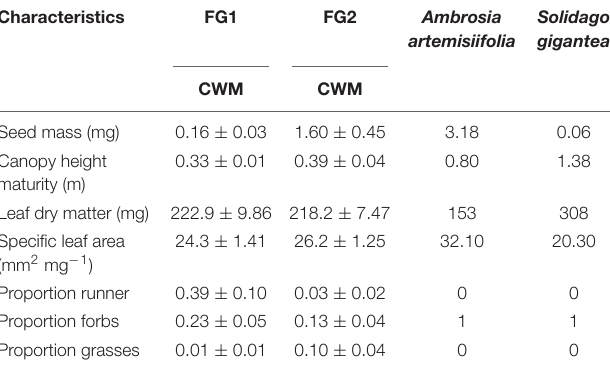
TABLE 2 | Community weighted means (CWM ± SE) of each numerical trait selected calculated for the two communities (FG1, 2) and average values of the same traits for both invasive alien species ( Ambrosia artemisiifolia and Solidago gigantea ).